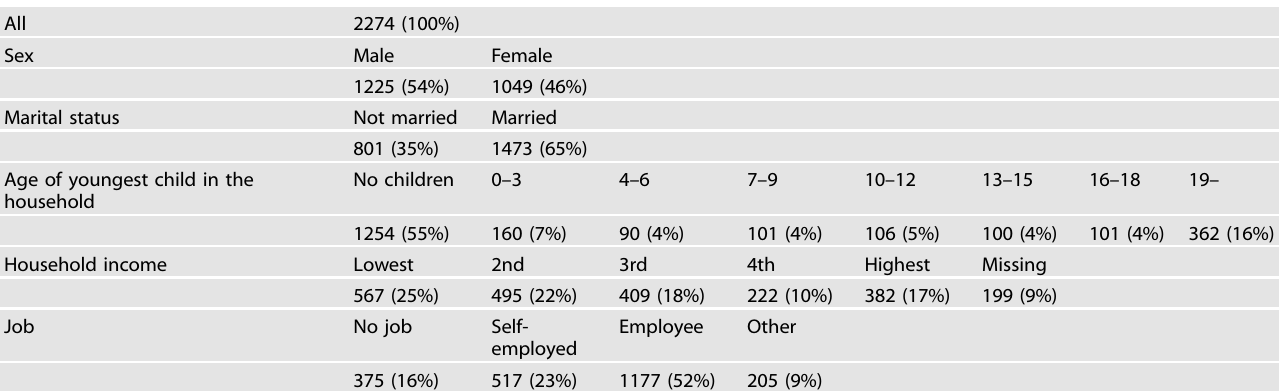
Table 1. Characteristics of study population ( N =